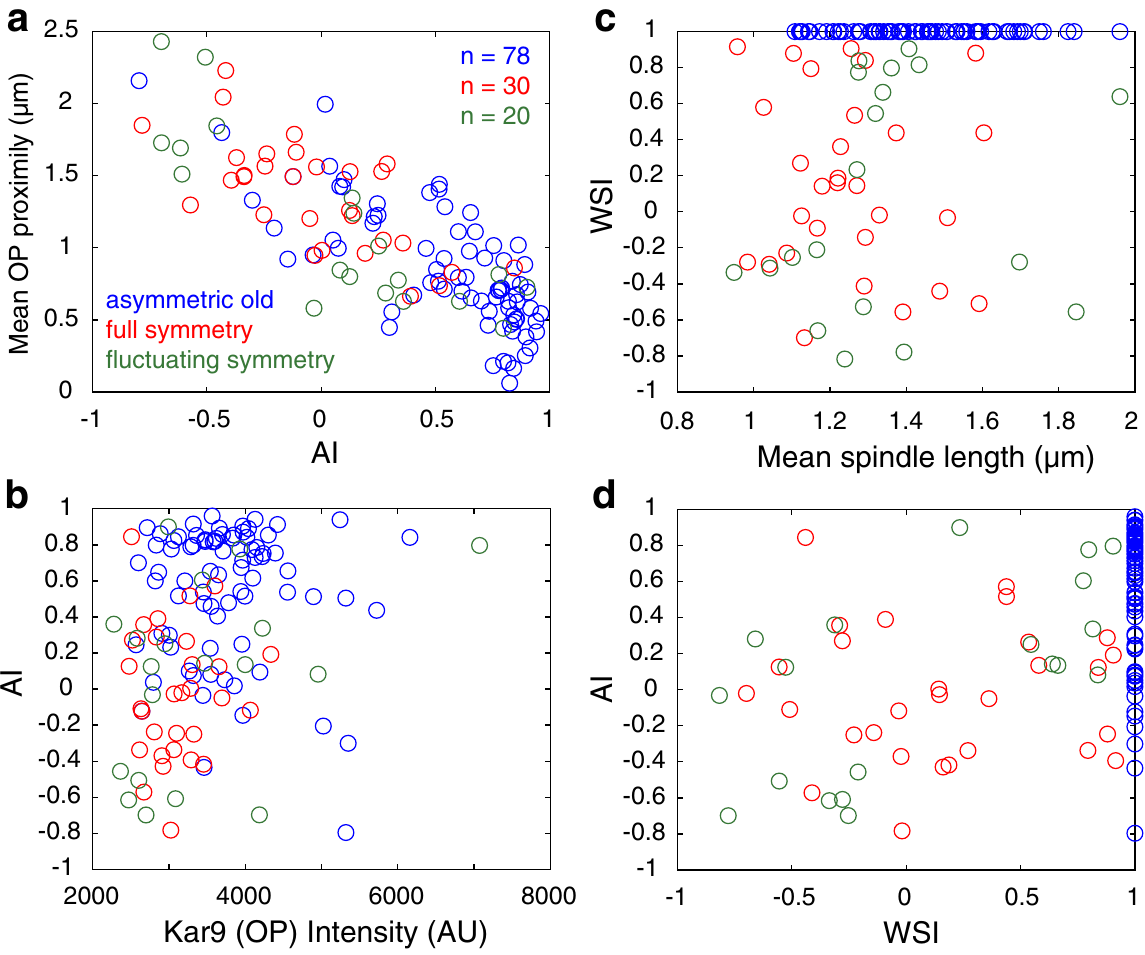
Figure 3. Kar9 bias to a given pole does not influence spindle alignment in wild-type cells. ( a ) Old pole (OP) proximity to the bud neck decreases as alignment index (AI) increases, irrespective of symmetry state. ( b ) Signal intensity of Kar9 associated with the old pole is distributed between 2000 and 4000 AU in most cells, and uncorrelated with symmetry state and alignment. ( c ) WSI, representative of Kar9 bias for a given pole, is insensitive to metaphase progression. ( d ) Spindle alignment is largely unaffected by Kar9 bias in symmetric onto the polarity axis, resulting in a one-dimensional (1D) projected length. The 1D length is plotted versus the true 3D length to determine alignment. The spindle is aligned when 1D and 3D lengths are comparable. To simplify the analysis, we defined an alignment index (AI) as the mean ratio of 1D to 3D length for each spindle. A numerical value of AI ≈ 1 indicates proper alignment and orientation (old pole proximal to the bud). A numerical value of AI ≈ − 1 implies mis-oriented alignment (new pole proximal the bud). All other AI values ranging from − 1 to 1 designates various degrees of misalignment, where an AI ≈ 0 indicates the spindle is perpendicular to the polarity axis. Regardless of genotype, both full and fluctuating symmetry spindles were broadly distributed around an AI value of 0, indicating poor alignment (Fig. 2c,d). This is consistent with a regime in which either the new or old pole can be transiently directed towards the bud neck and is the expected outcome of the symmetric state (Fig. 1a). In contrast, the majority of WT asymmetric spindles were biased toward a high AI (Fig. 2c). The small fraction of asymmetric kar9-AA spindles showed variation in their alignment, with a broader distribution for AI relative to WT asymmetric spindles (Fig. 2d). All 3D spindle measures are consistent with 2D alignment measures (Supplementary Fig. S1). In order to examine the functional relevance of the observed symmetry state diversity, we explored the rela- tionship between various traditional parameters of interest with AI in WT cells. As expected, AI and proximity of the old pole to the bud neck were inversely proportional; as alignment is improved and AI approaches 1, the old pole approaches the bud neck, decreasing the distance between them. This trend was observed irrespective of symmetry state; however the majority of asymmetric old cells were more proximal to the bud neck than sym- metric cells (Fig. 3a). Kar9 intensity at the old pole is often explored in relation to spindle alignment and symmetry breaking. We examined whether Kar9 signal intensity could accurately predict spindle alignment. Regardless of symmetry state,